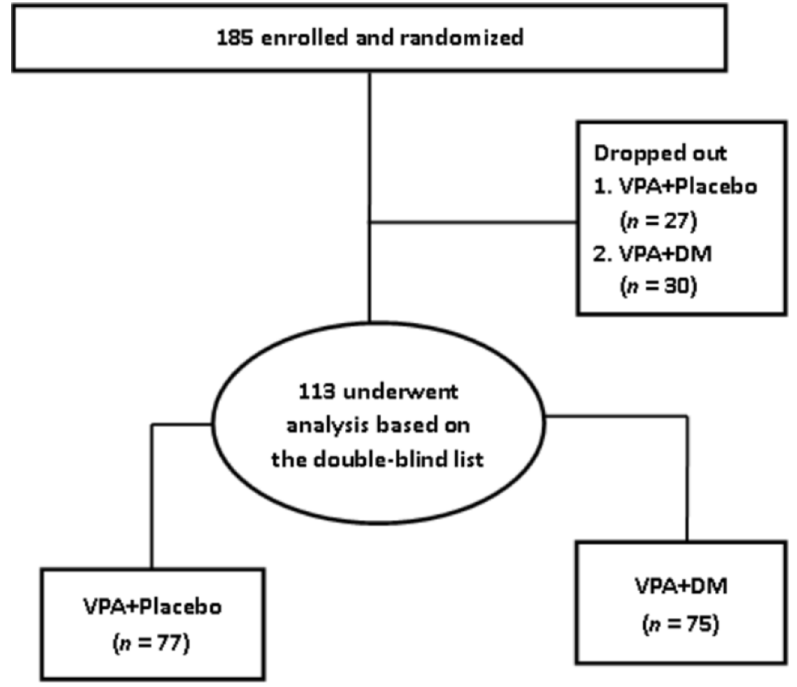
Figure 1. Consort flow chart of recruitment.